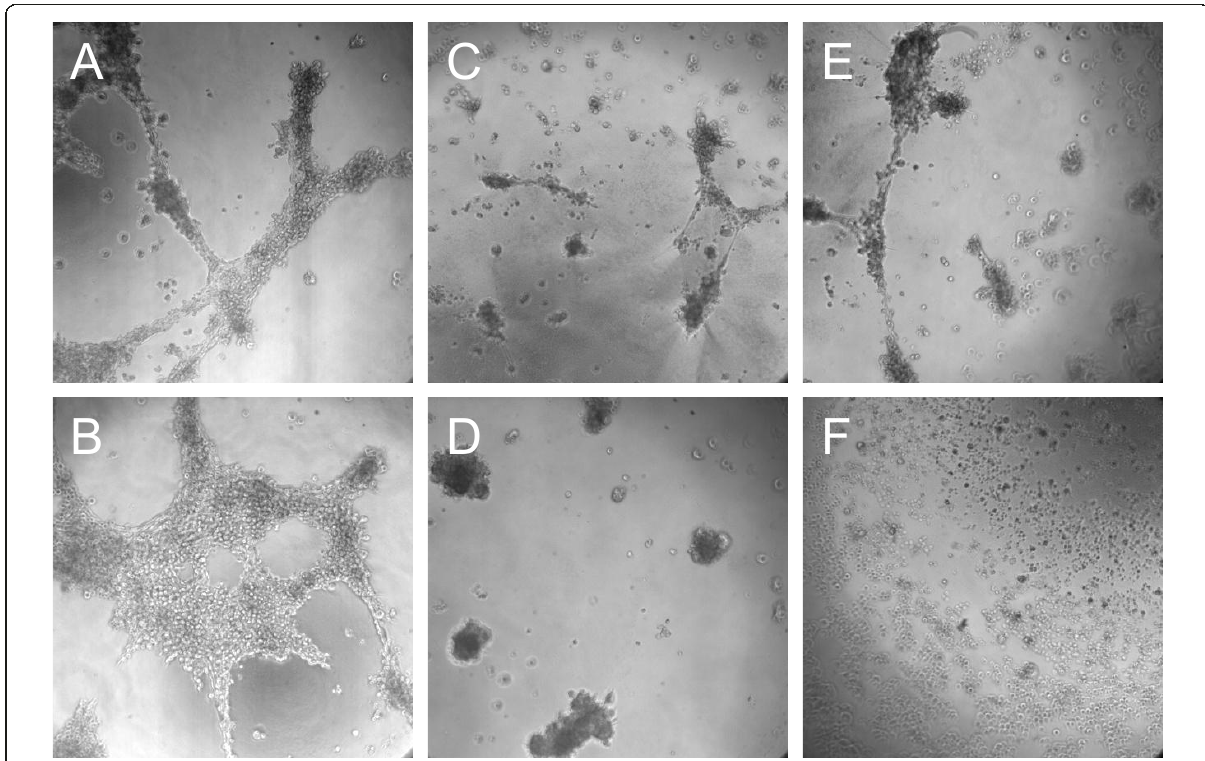
Figure 5 Assessment of anti-invasive activity of Boswellia sacra essential oil . Matrigel basement membrane matrix (100 μ l) was transferred to each well of 96-well culture plates and allowed to polymerize at 37 o C. MDA-MB-231 cells (4 × 10 4 ) were resuspended in 100 µl growth media and added on the top of the polymerized Matrigel (A and B). In separate wells, cells were either mixed with 100 µl of 78 o C essential oil at (C) 1:800 or (D) 1:600 dilution, or 100 o C essential oil at (E) 1:1,500 or (F) 1:1,200 dilution and layered on the top of Matrigel. Formation of vascular-like networks was assessed at 24 hours following oil treatment. The capabilities of MDA-MB-231 cells in forming networks of tubes and Boswellia sacra essential oil in suppressing the cellular network formation on Matrigel are observed at 100× magnification. Experiments were repeated at least 3 times and representative images are